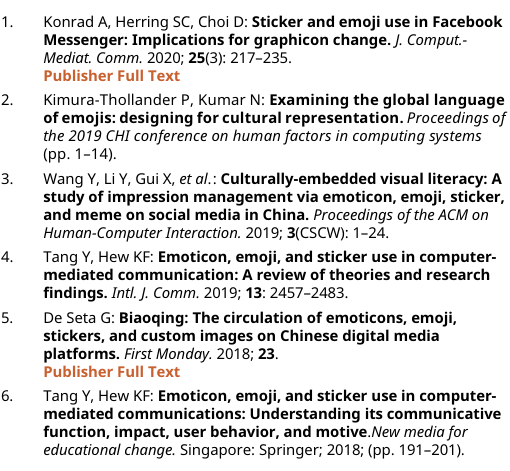
The project contains the following underlying data: